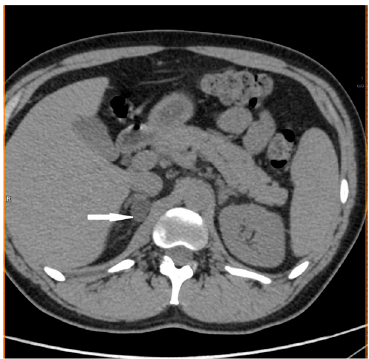
Figure 1. Adrenal cortical adenoma. Abdomen CT, transverse cross-section.